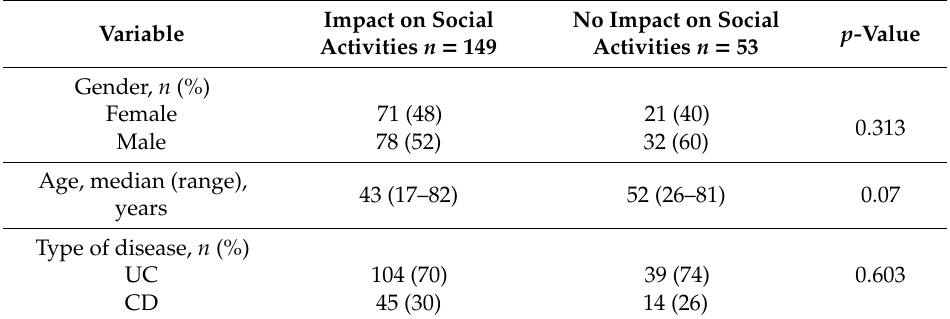
Table 4. Impact of IBD on social activities in the 202 patients with inactive disease.